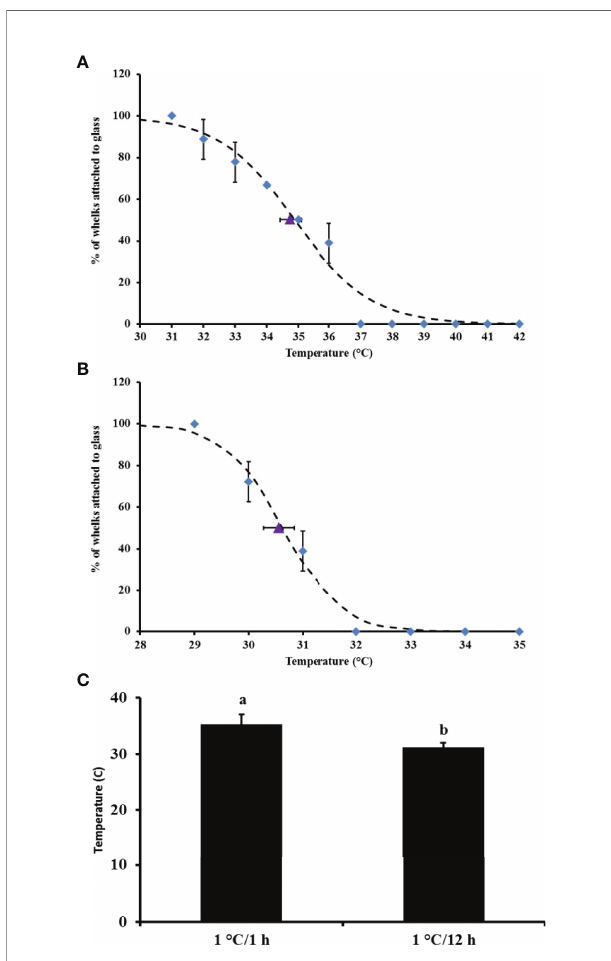
FIGURE 1 | Percentage of Dicathais orbita remaining attached to the glass tank (blue diamonds) ± SD and mean CTMax (purple triangle) ± SD (n = 6 per tank) for (A) CTMax short-term with fast warming rate of 1°C/1 h temperature increment; (B) CTMax long-term with slow warming rate of 1°C/12 h temperature increment; and (C) the mean CTMax of D. orbita (pooled data from all the replicate tanks) at 1°C/1 h and 1°C/12 h (n = 6 per tank). Different superscript letters indicate signi fi cant